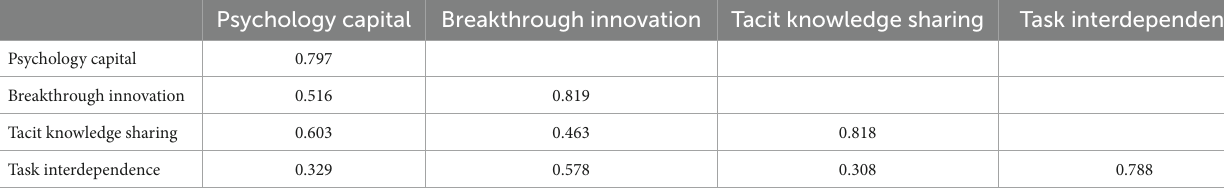
TABLE 4 Results of Pearson correlation analysis between factors and AVE square root